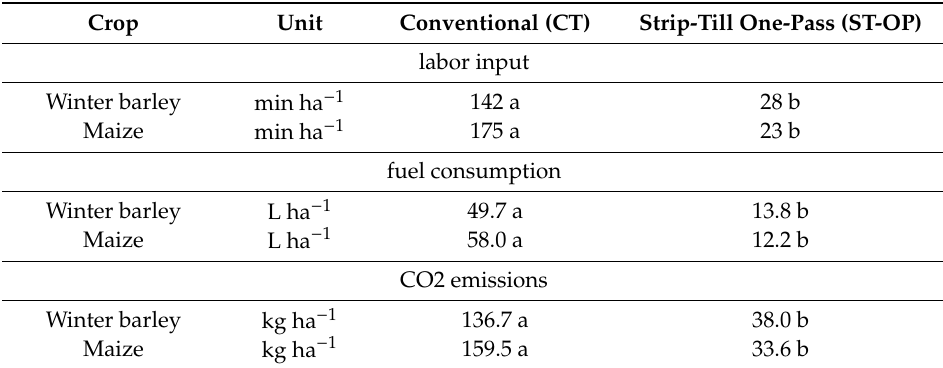
Table 5. Inputs and CO 2 emissions as a result of di ff erent tillage systems. Conventional (CT), reduced (RT), and strip-till one-pass